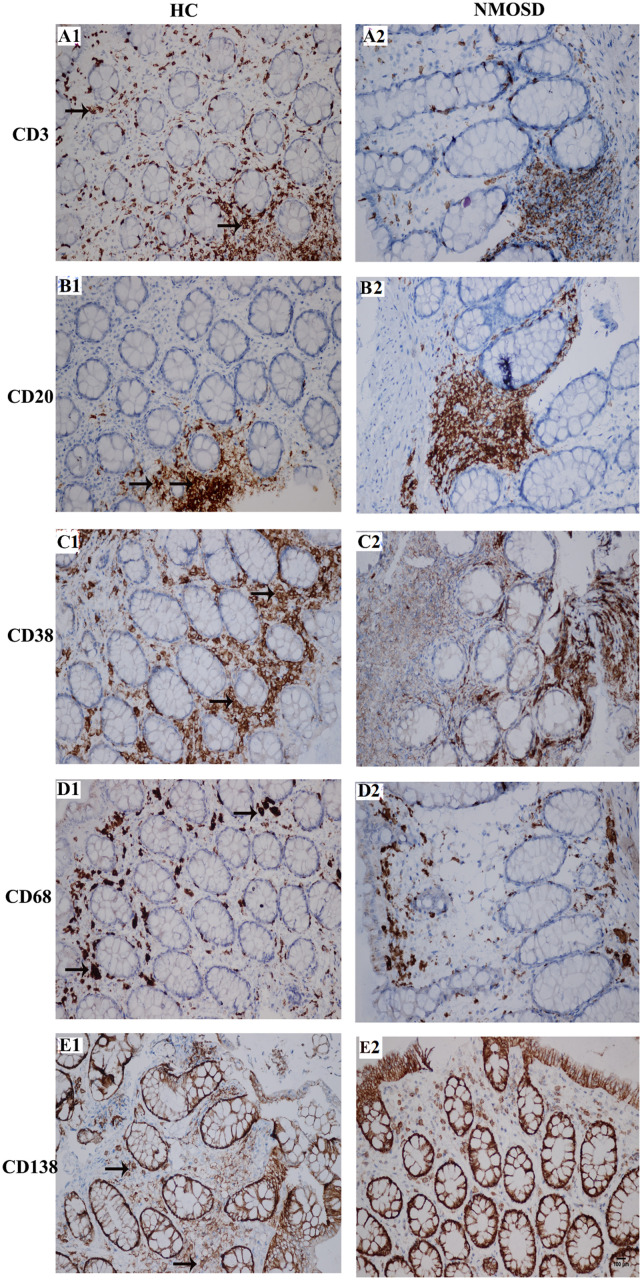
Photomicrographs showing the immunohistochemical staining for inflammatory cell markers using the DAB visualization method. These markers include CD3 [a marker for T cells, (A1,A2)], CD20 [a marker for B cells, (B1,B2)], CD38 [markers for activated lymphocytes and plasmocytes, (C1,C2)], CD68 [a marker for macrophages, (D1,D2)] and CD138 [a marker for plasmocytes, (E1,E2)]. Positive staining is brown in color (black arrows). All slides were counterstained with hematoxylin (blue). The scale bar (100 μm) in (E2) is equal in all photos.